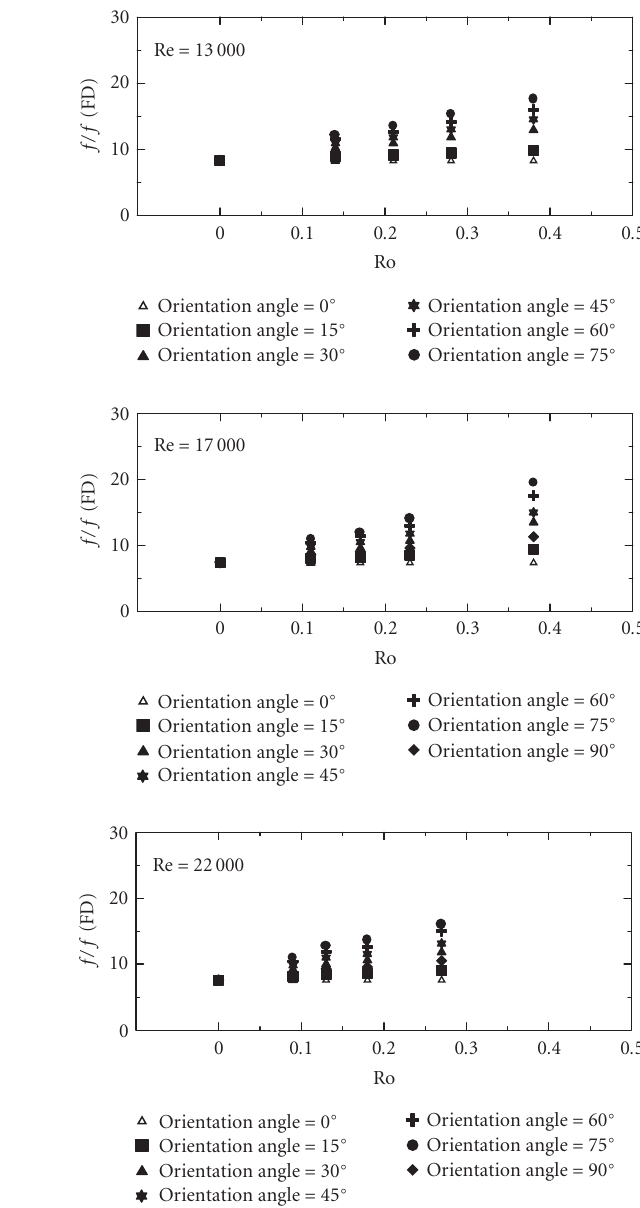
Figure 5: E ff ect of the orientation angle for 90 ◦ ribbed radial out- ward flow channel for a rib pitch-to-height ratio of 5,5.